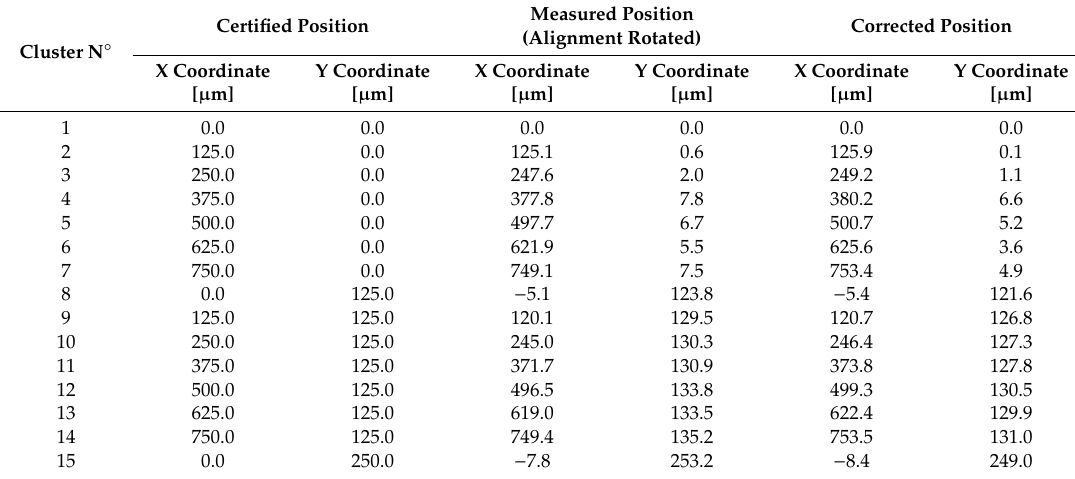
Measured Position (Alignment